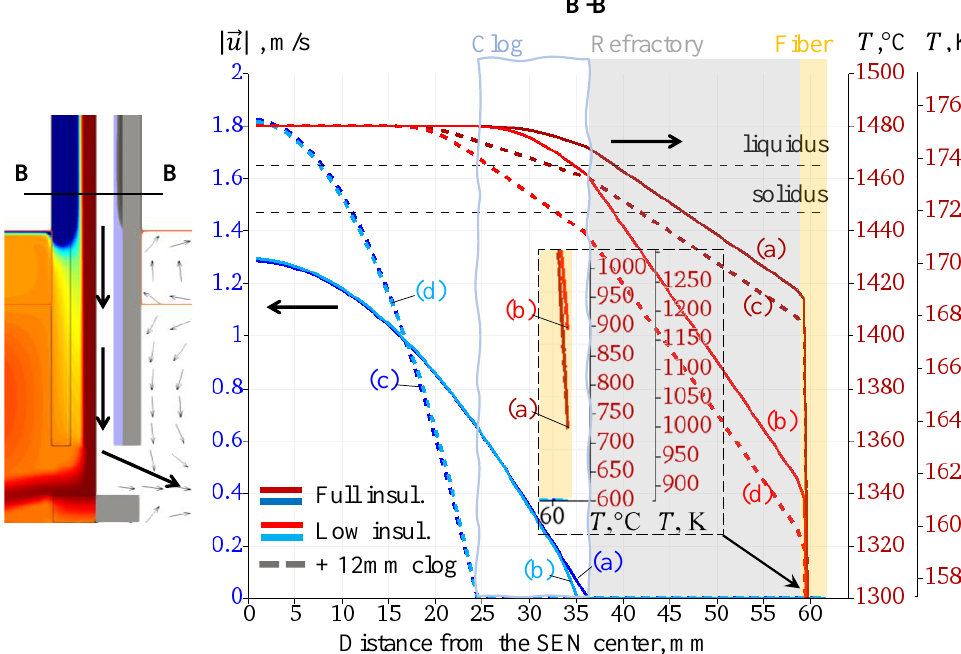
Figure 10. Velocity magnitude profile and the temperature distribution along the B-B line 50 mm above the slag layer for the cases ( a , b ) of a fully and partially insulated SEN without clogging (solid lines) and ( c , d ) considering a uniform 12 mm clog layer (dashed lines); the SEN outer surface temperatures are shown in a zoomed view.